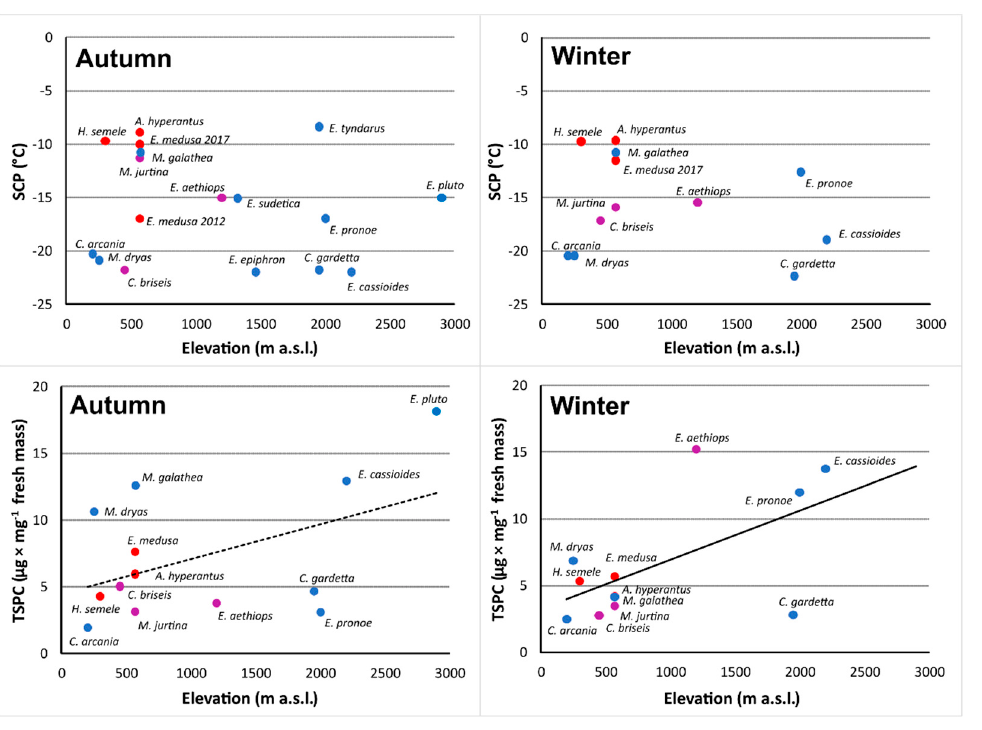
Figure 2. Relating average supercooling points (SCP) and total sugar and polyol concentrations, TSPC, detected for European Satyrinae species, to elevations of their origin. SCP did not correlate with elevation (Autumn: r = − 0.163, t ( n =17) = − 0.64, p = 0.53; Winter: r = − 0.25, t ( n =12) = − 0.82, p = 0.43). A dashed line shows a tendency towards positive correlation (r = 0.48, t ( n =13) = 1.80, p < 0.1), a solid line shows a significant positive correlation (r = 0.60, t ( n =12) = 2.37, p < 0.05). Color codes: freeze ‐ avoidant species (unable to survive freezing of body fluids) are blue, freeze ‐ tolerant species (surviving freezing of body fluids) red, mixed ‐ strategy species (partly surviving, partly not) violet.